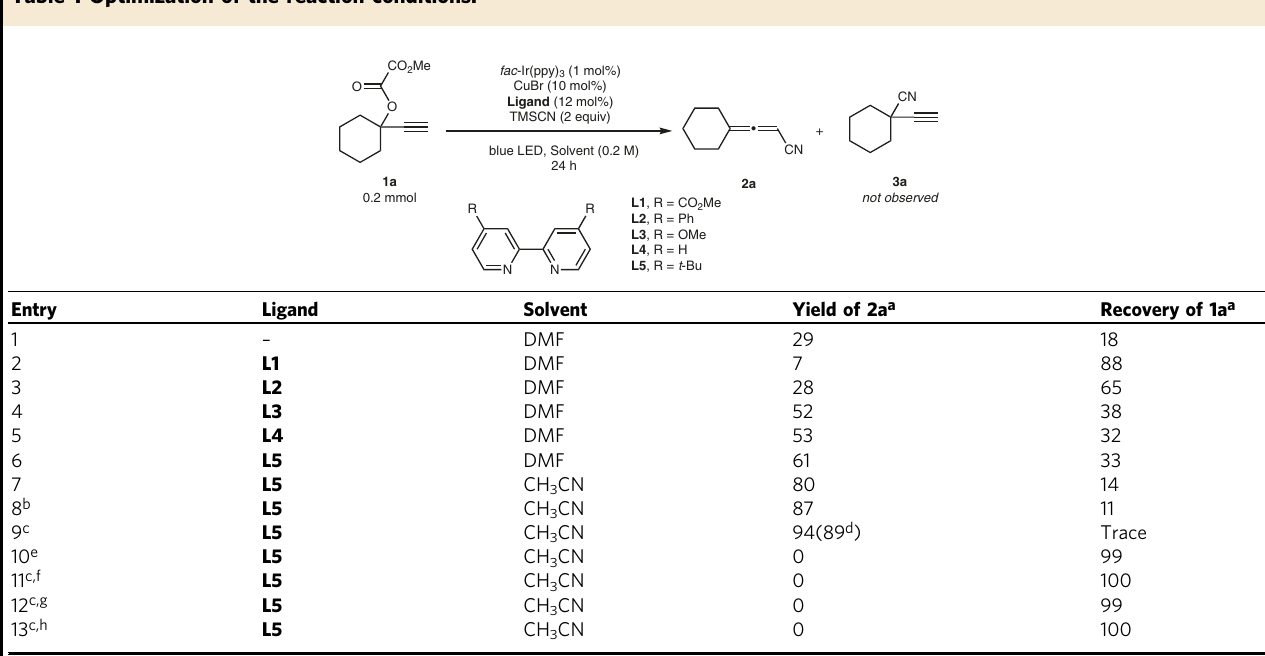
Table 1 Optimization of the reaction